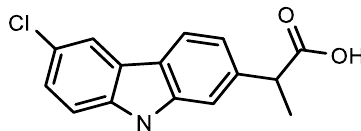
Figure 1. Structure of carprofen ( 1 ) .